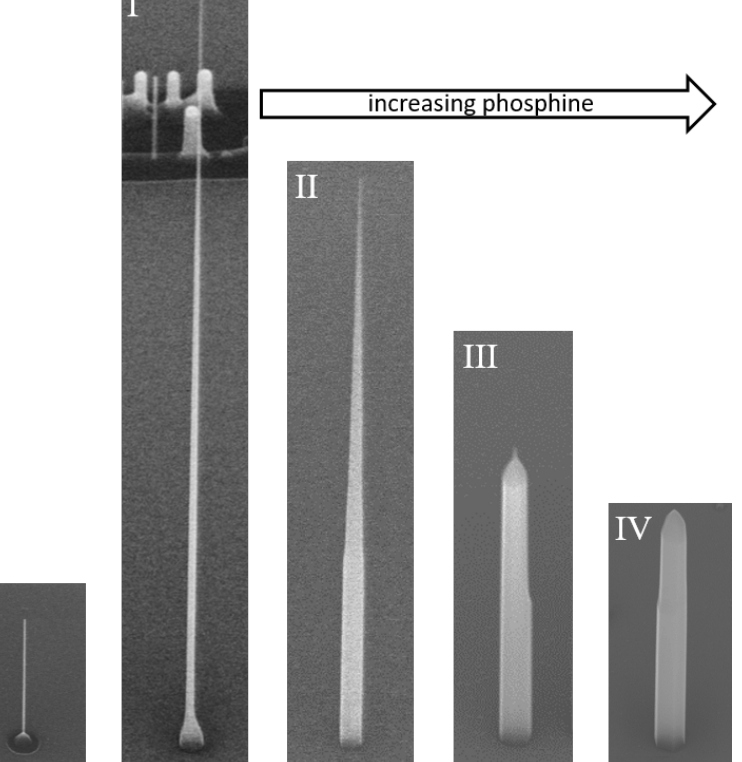
Figure 4. SEM images viewed at 45 ◦ of nanowires grown under different cladding conditions. Image T corresponds to the nanowire template on which the cladding material is grown. Images I through IV correspond to nanowires clad using different PH 3 flow rates, from 3 to 15sccm, respectively. Scale bar is